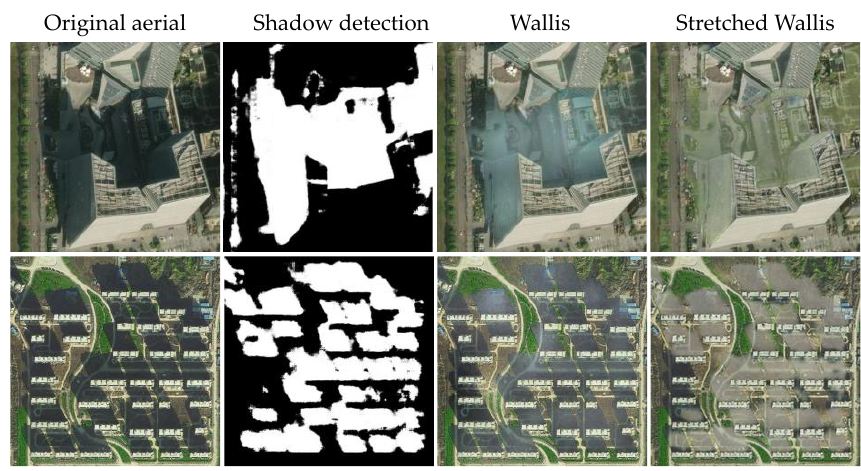
Figure 1. Shadow compensation results using Stretched Wallis.